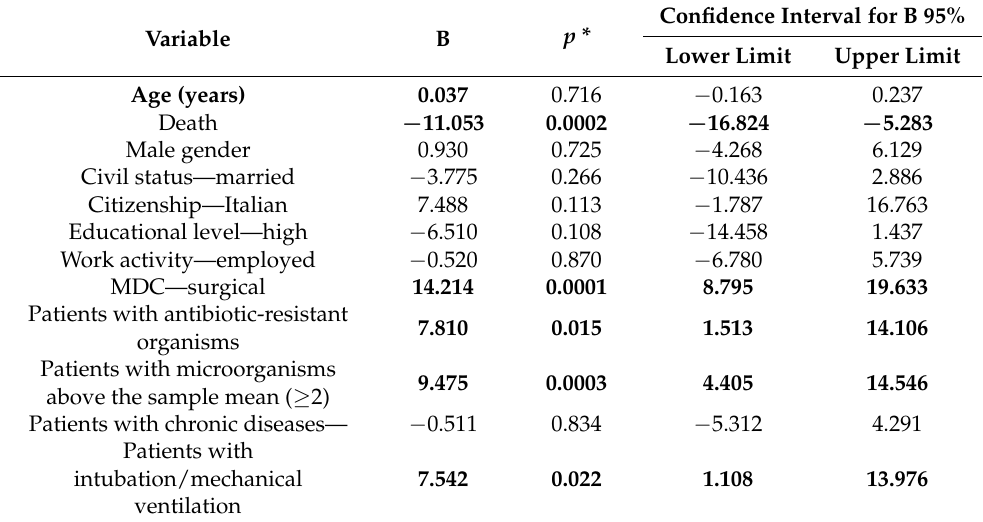
Table 5. Multivariable linear regression for the dependent variable of length of stay (in